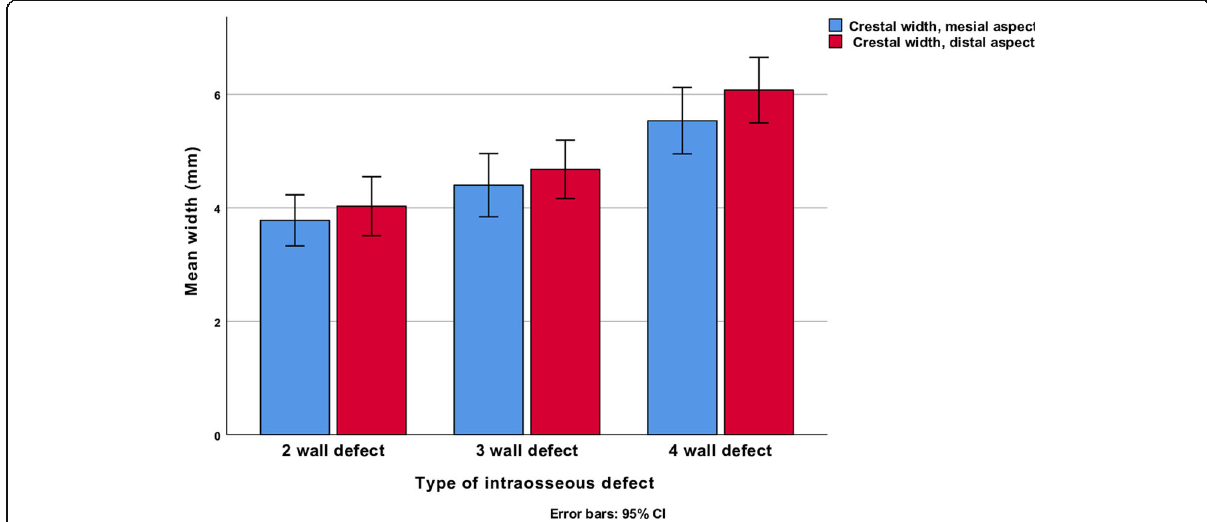
Fig. 1 Crestal width and defect configuration at baseline (mean values and 95% error bars)